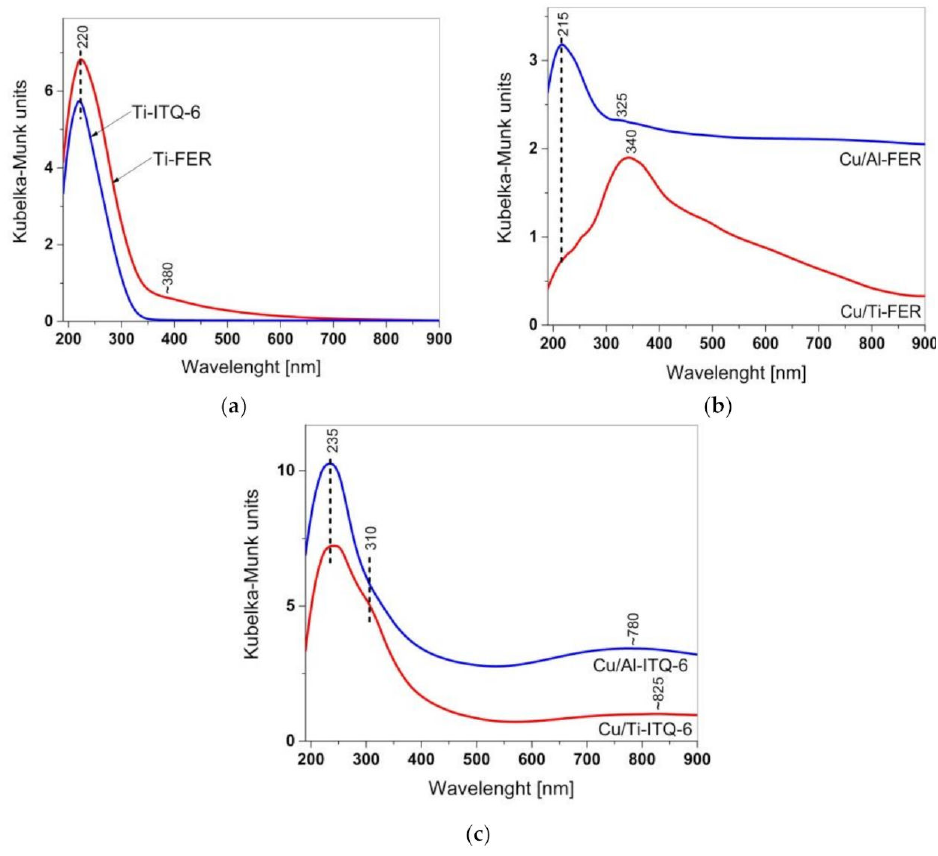
Figure 4. UV-vis DR spectra of Ti-zeolites ( a ), ferrierites modified with copper ( b ) and ITQ-6 zeolites modified with copper ( c